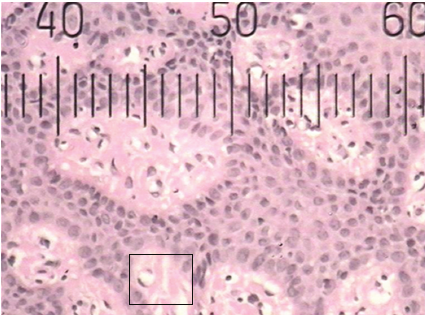
Figure 1: Histopathological photograph of gingival tissue in smoker showing smaller blood vessels.